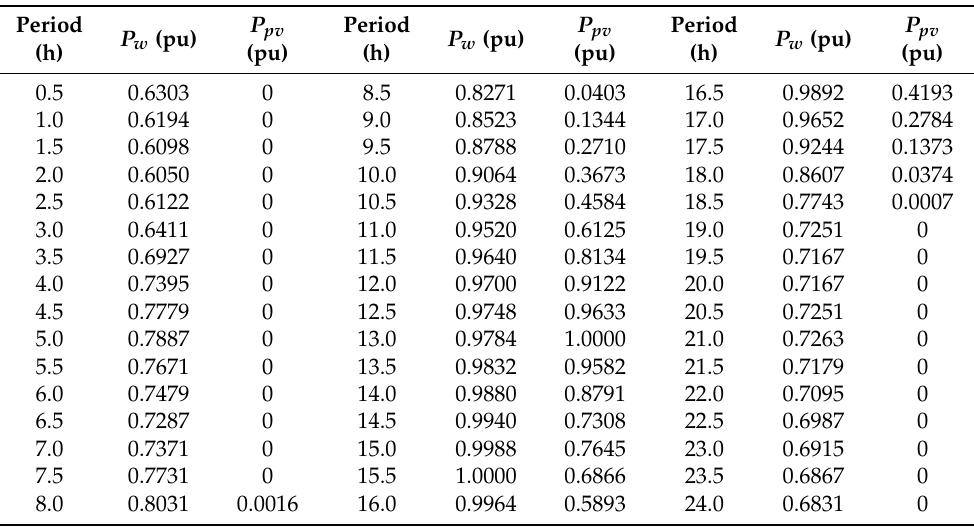
Table 5. Daily behavior of the renewable energy